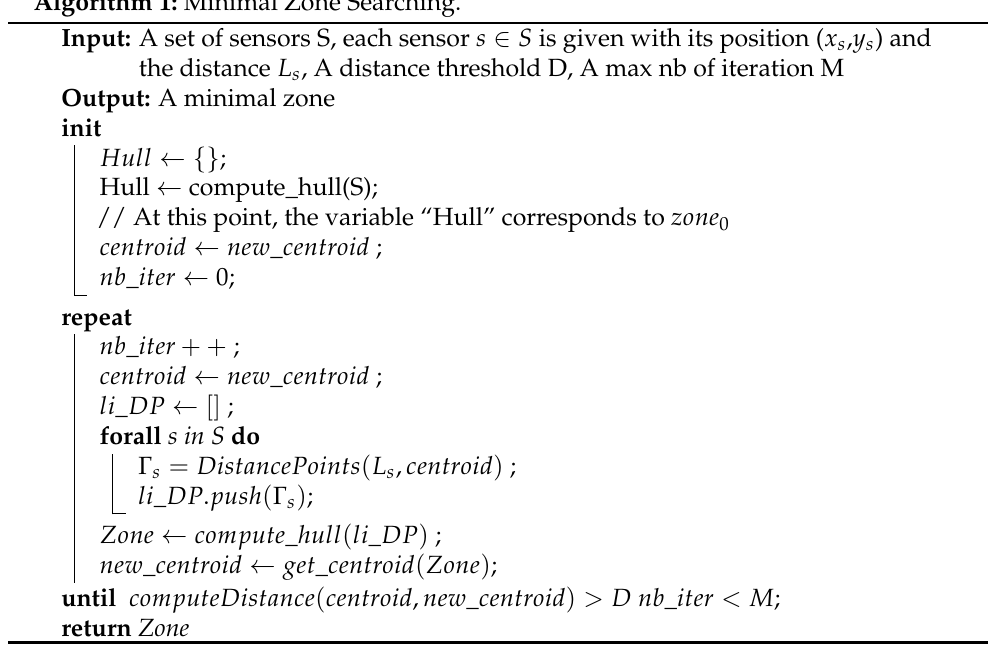
Algorithm 1: Minimal Zone